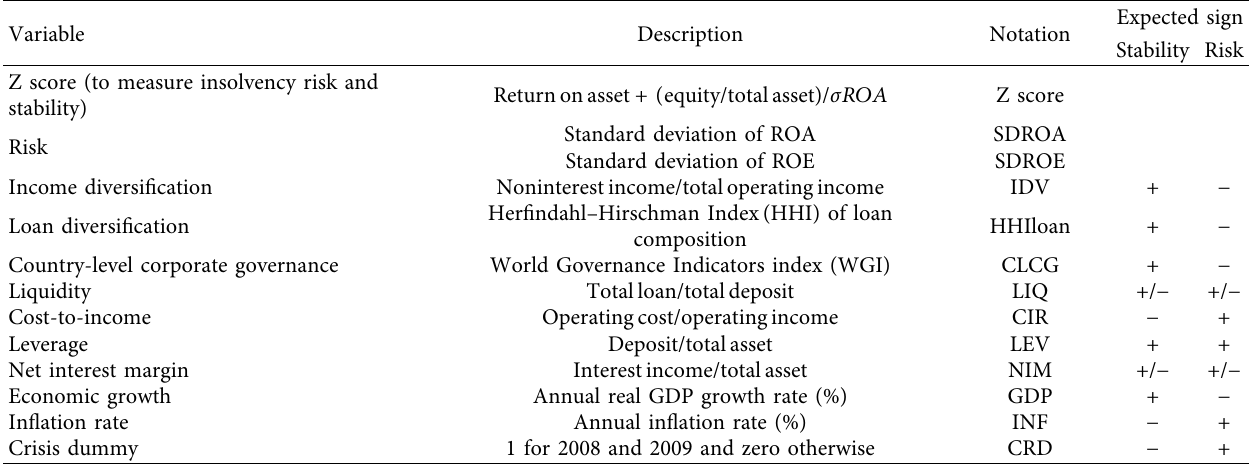
Table 2: Description of variables and expected